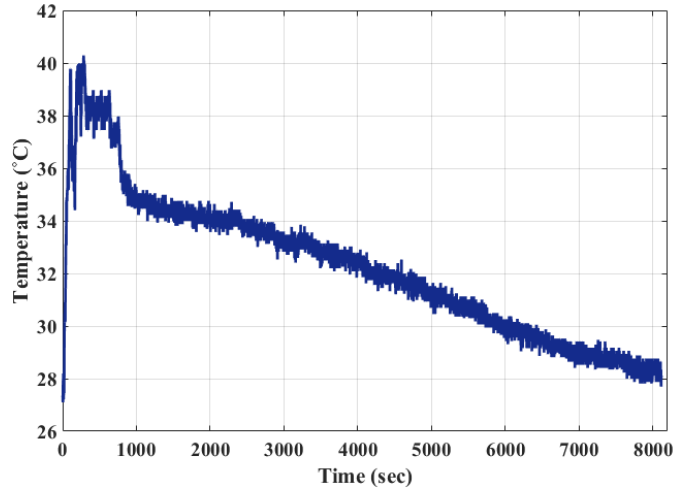
Figure 14. Temperature of the battery during the proposed charging.